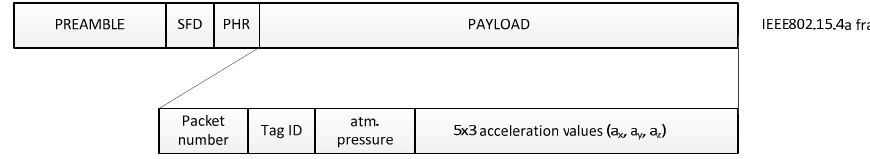
Table 1. Tag’s components current consumption.